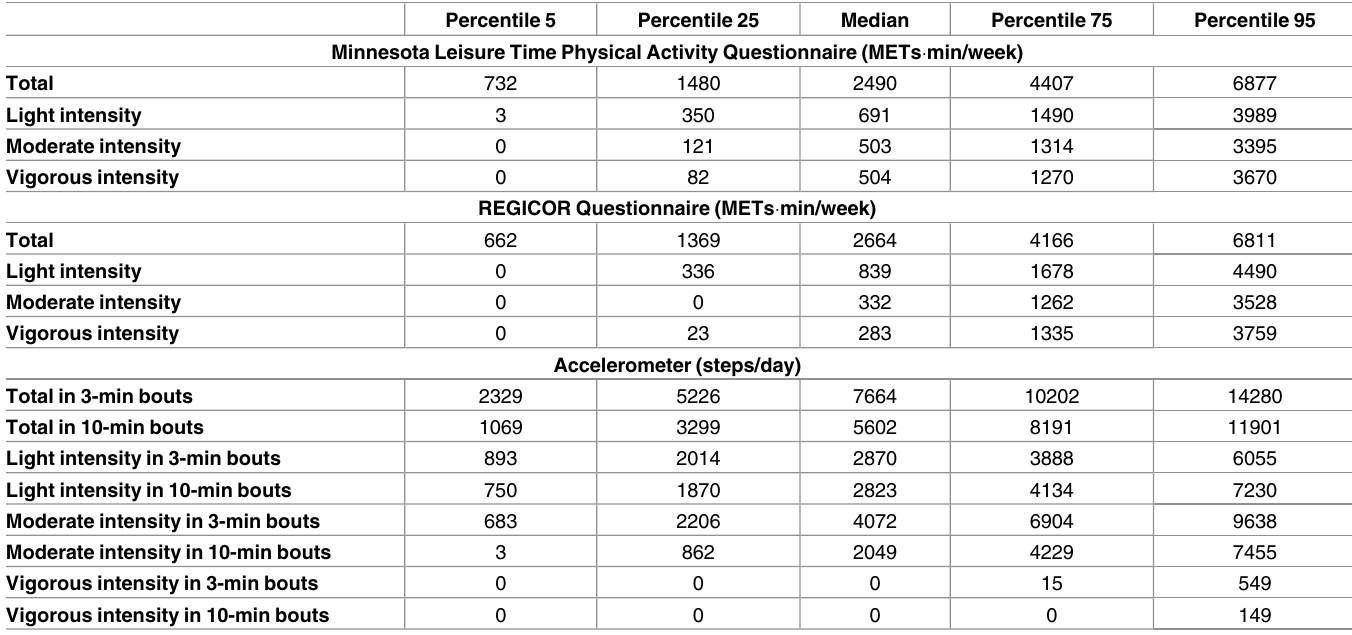
Table 3. Distribution of study participants’ physical activity estimations obtained with the questionnaires and with the